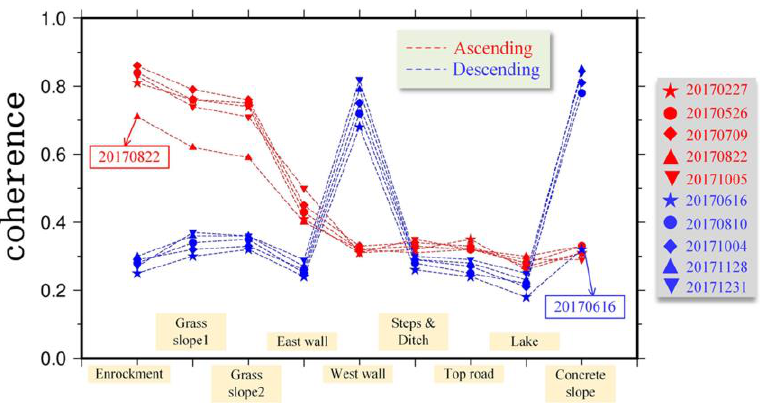
Figure 12. The coherence of the dam surface changing in the TSX-SL time series.